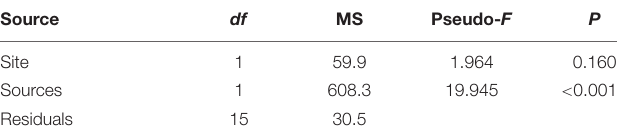
TABLE 2 | Permutational multivariate analysis of variance (PERMANOVA) results to test the significance of variabilities of isotope ( δ 13 C and δ 15 N) values of primary producers between sites and